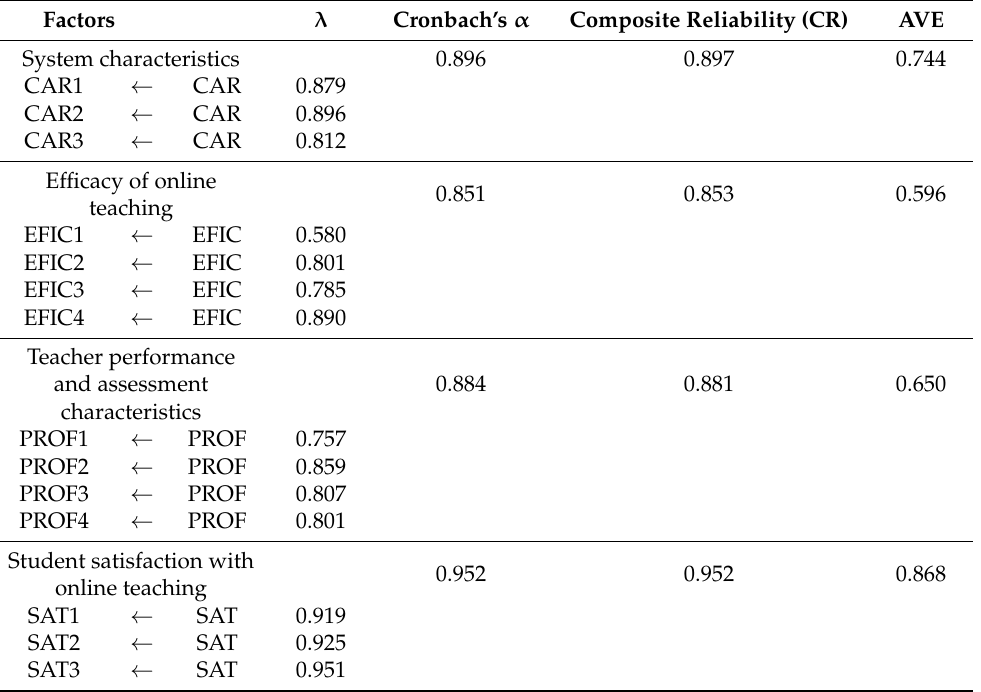
Table 3. Standardized estimations for observable indicators, Cronbach’s α values, convergent validity, and reliability